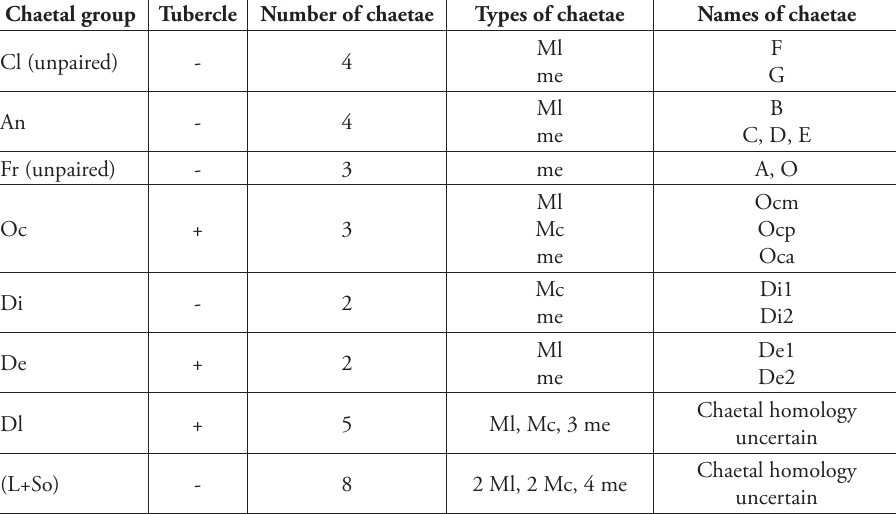
Table 3a. Chaetotaxy of Yuukianura deharvengi sp. n.: cephalic chaetotaxy of dorsal side. Chaetal group Tubercle Number of chaetae Types of chaetae Names of chaetae